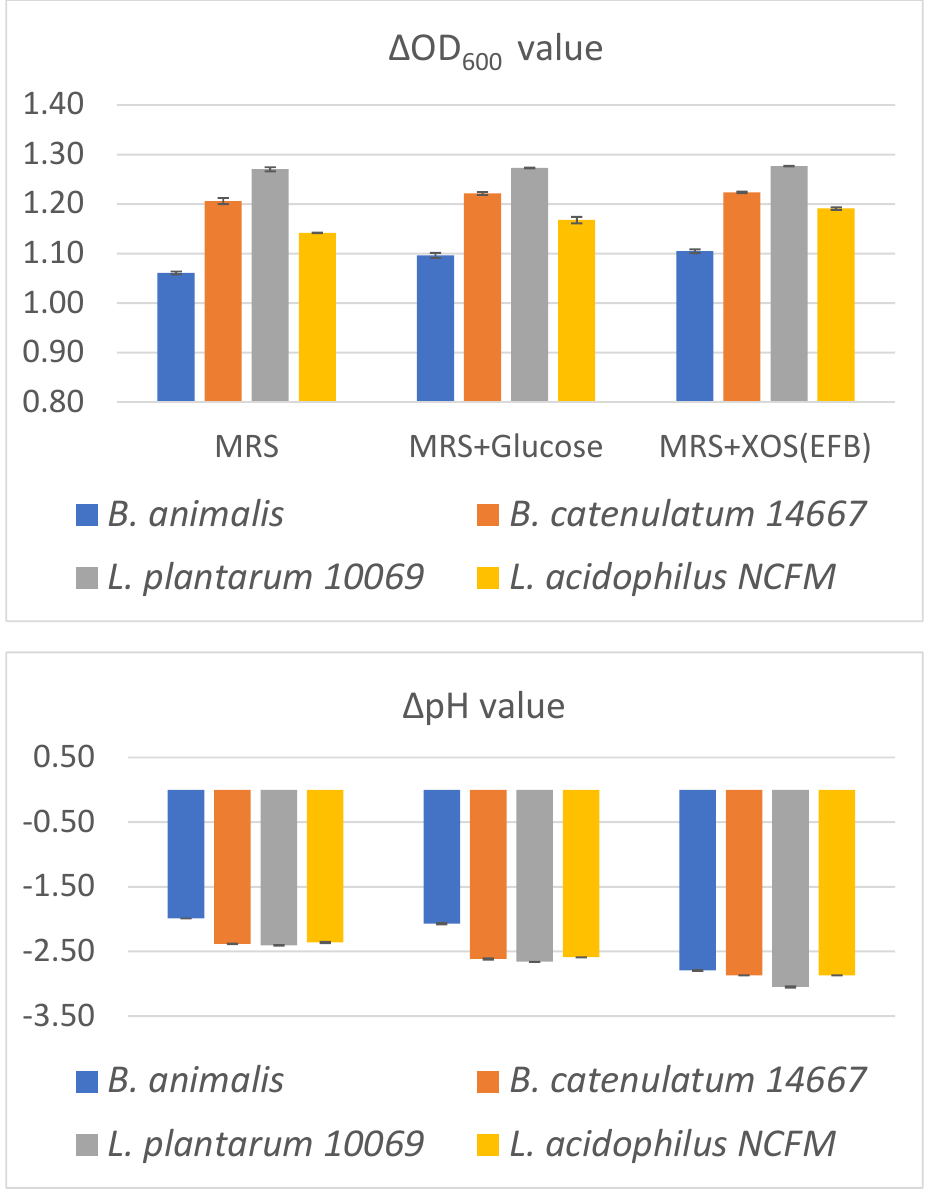
Figure 5. Biomass increment (∆ OD 600 ) and pH decline ( ∆ pH) of Bifidobacteria and Lactobacillus cultured in MRS medium without and with glucose or XOS for 72 h. Each error bar represents the standard deviation of triplicate experiments.